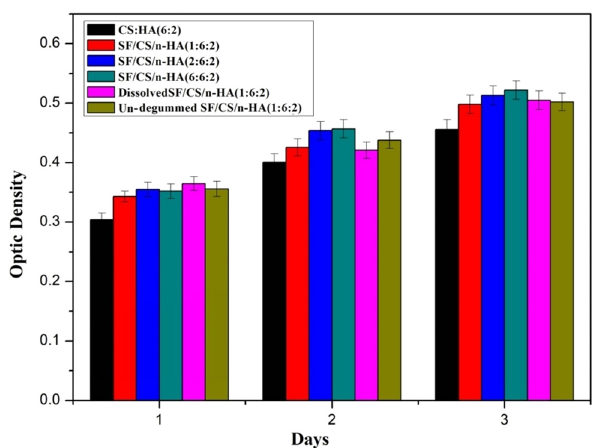
Figure 9: MTT assays of cell culture on sample